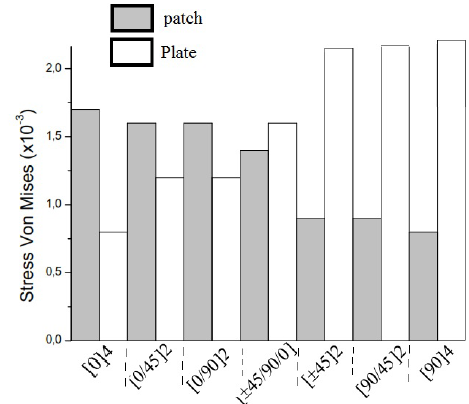
Figure 15. Influence of the patch stacking sequence on the stress σ * for a plate [45/90]